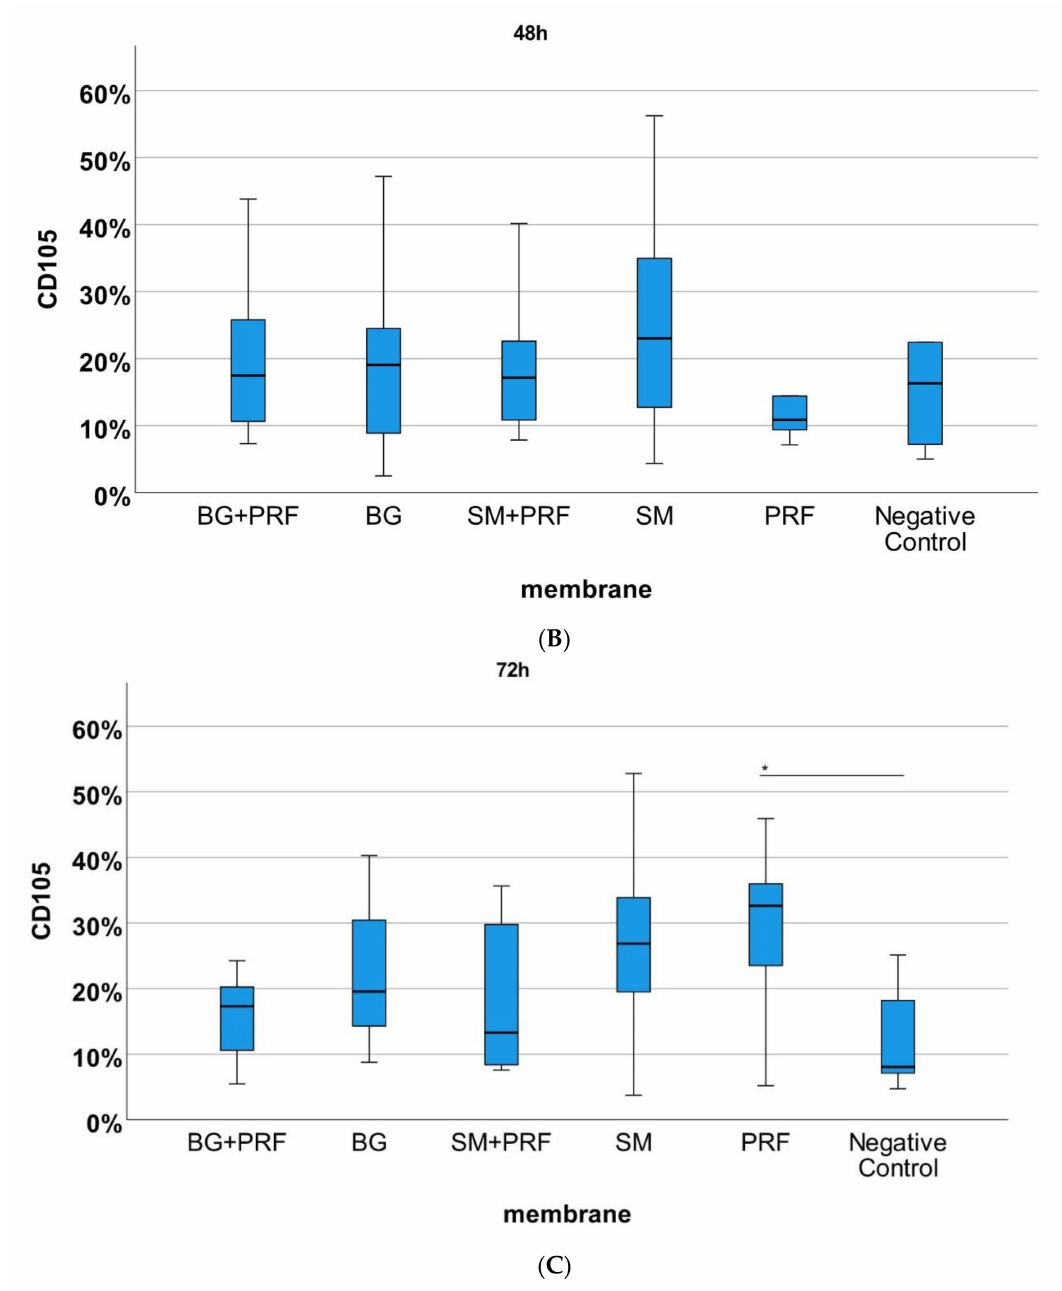
Figure 8. Analysis of CD105 immunohistochemical staining for the respective matrix (BG + PRF: Bio-Gide ® with PRF, BG: native Bio-Gide ® , SM + PRF: Symbios ® with PRF, SM: native Symbios ® , PRF, negative control). ( A ) 24 h, ( B ) 48 h, ( C ) 72 h of incubation. * marks statistically